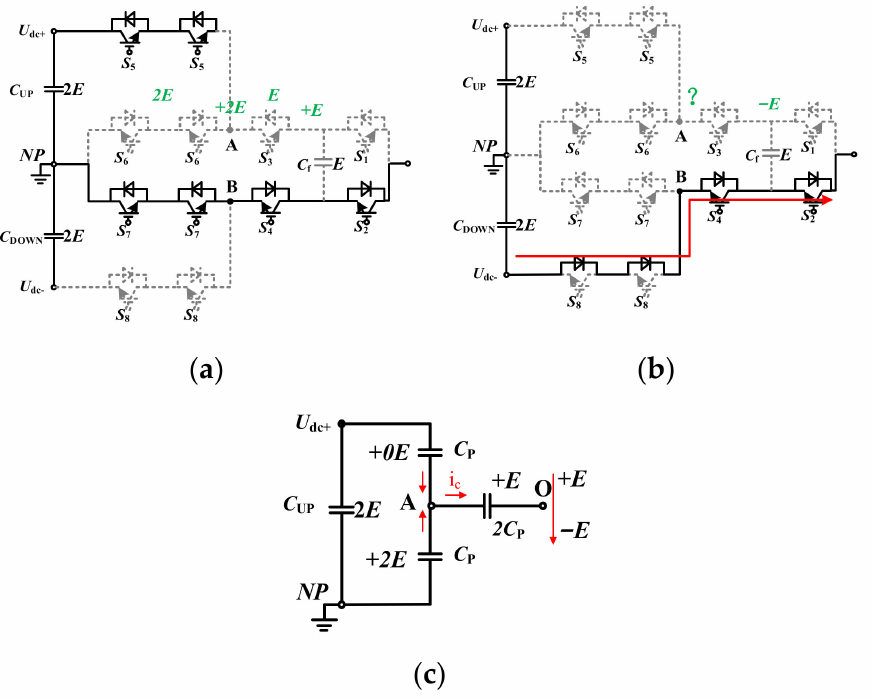
Figure 6. ( a ) Initial potential difference of V5-1. ( b ) Potential difference of V DANGER . ( c ) Equivalent circuit of the charging process from V5-1 to V DANGER